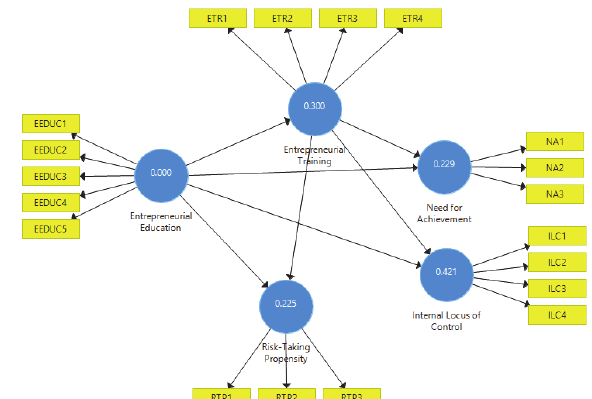
Fig. 3. Blindfolding Test of the Model Source: PlS